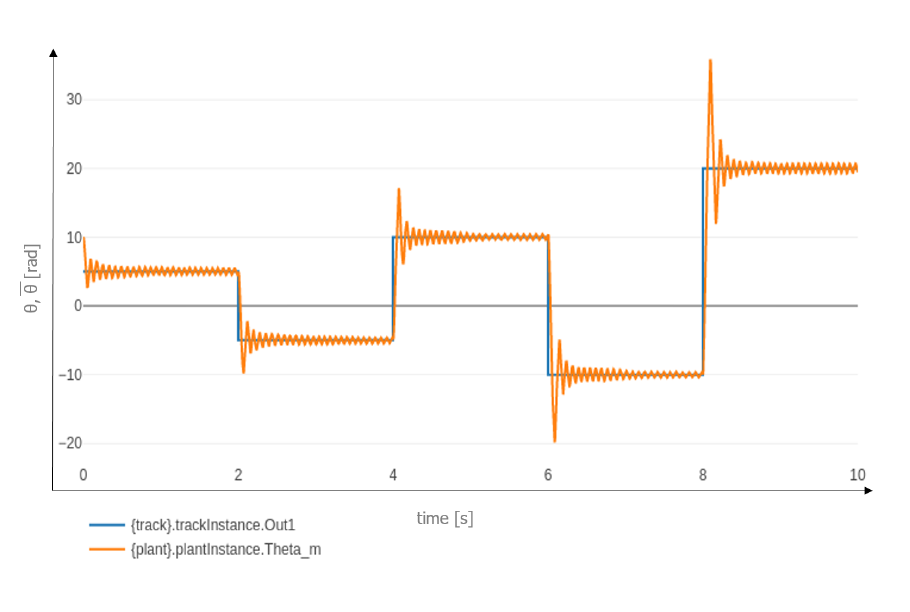
Figure 12. Co-simulation for K 11 = − 1000 and K 22 = −